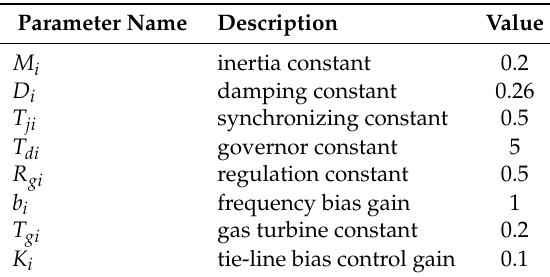
Table 1. Parameters of sub-system.